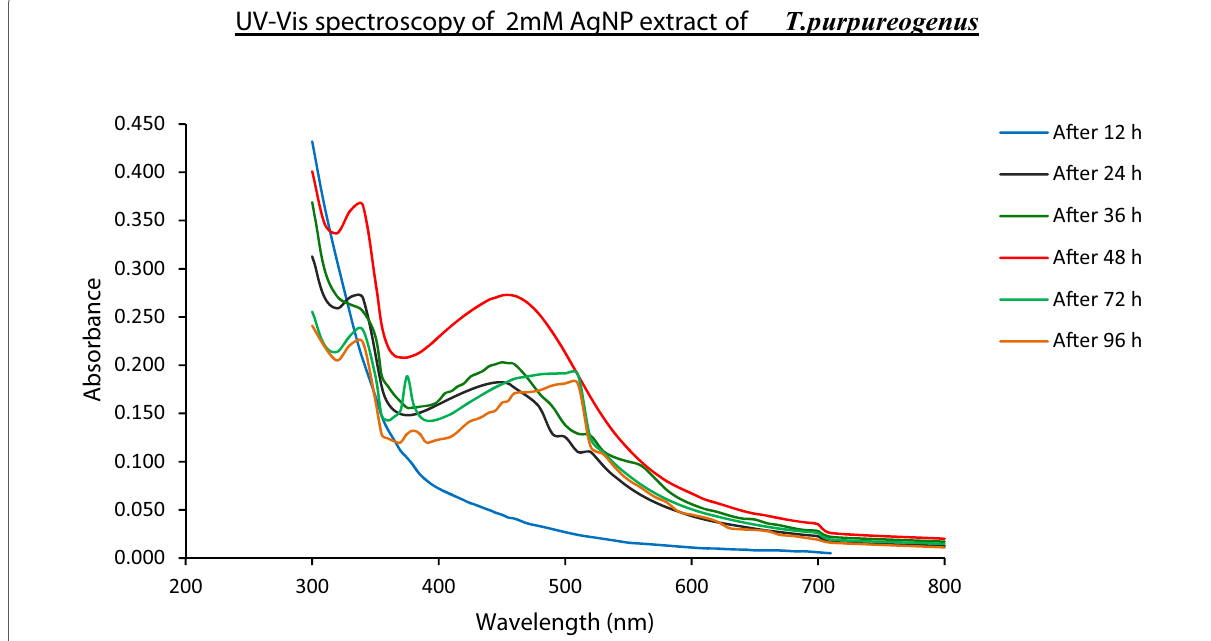
Fig. 2 UV–Vis spectroscopy of 2 mM AgNP extract of T.